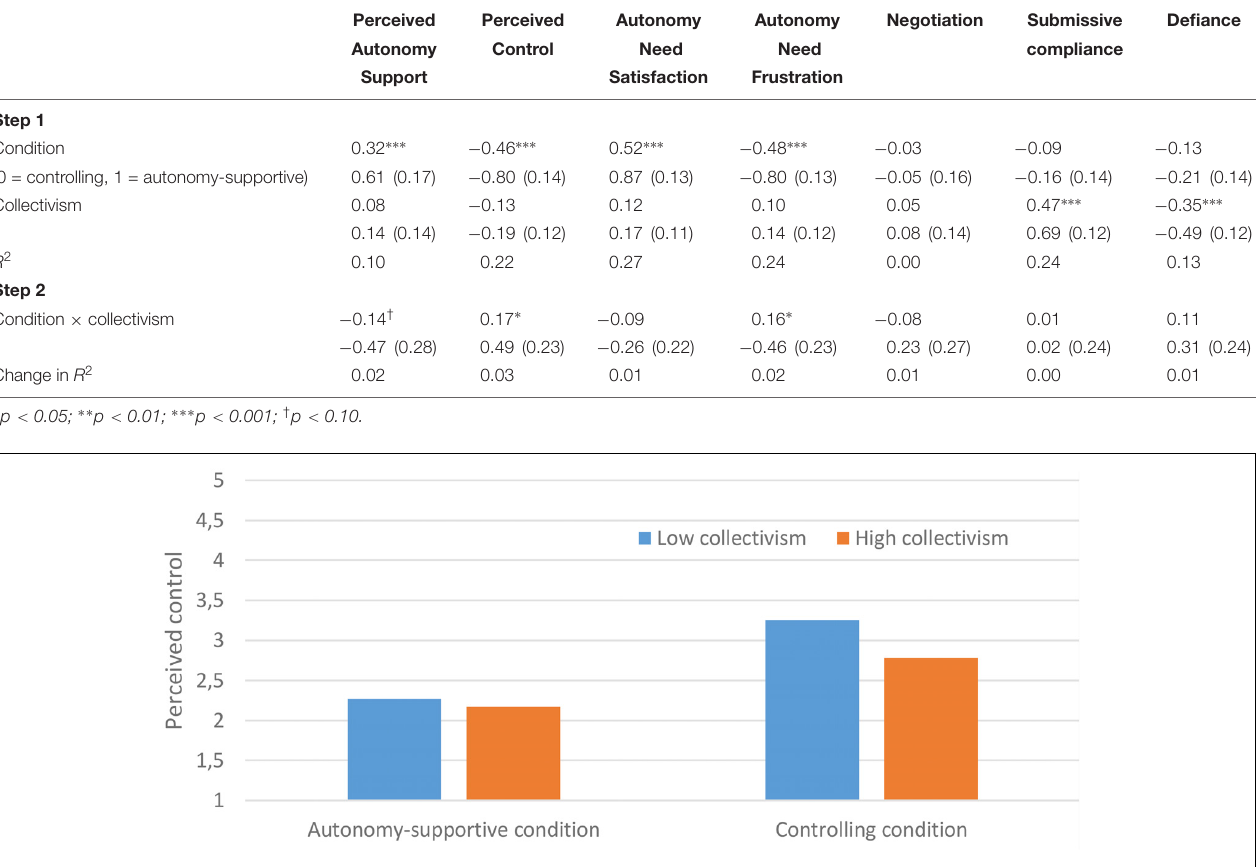
TABLE 3 | Interactions between collectivism and condition in the prediction of appraisals and responses to parental behavior (the first coefficients shown are standardized regression coefficients – the second coefficients shown are unstandardized coefficients – with standard errors between brackets).